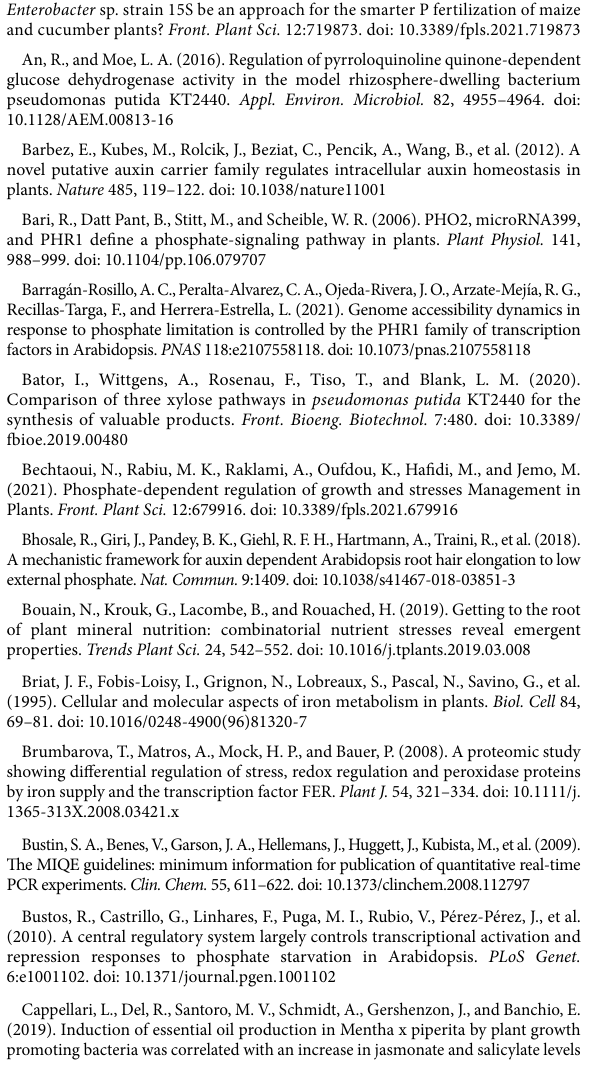
SUPPLEMENTARY TABLE 1 List and sequences of used primers. SUPPLEMENTARY FIGURE 1 Effects of beneficial bacteria on phosphate homeostasis-related genes in Arabidopsis thaliana grown in different phosphate sources. Quantitative RT-PCR determinations of relative expression levels of the genes related to phosphate homeostasis PHR1-1 ( PHOSPHATE STARVATION RESPONSE 1 ); PHL ( PHR1-LIKE 1 ); PHT1;1 ( PHOSPHATE TRANSPORTER 1;1 ); PHT1;4 . ( PHOSPHATE TRANSPORTER 1;4 ), and PHO2 ( PHOSPHATE 2 ). Plants were exposed to 1mm KH 2 PO 4 and 0mM Ca 3 PO 4 (Left panel) or 0.1mm KH 2 PO 4 /0.99mM Ca 3 PO 4 (right panel) for 0, 2, 24 h or 7 days (d). Simultaneously, plants were non- inoculated (WB) or inoculated with Paraburkholderia phytofirmans PsJN (PsJN) or Azospirillum brasilense Sp7 (Sp7). Normalization was performed with the housekeeping SAND family gene (AT2G28390). Asterisks indicate statistical significance among treatments in a